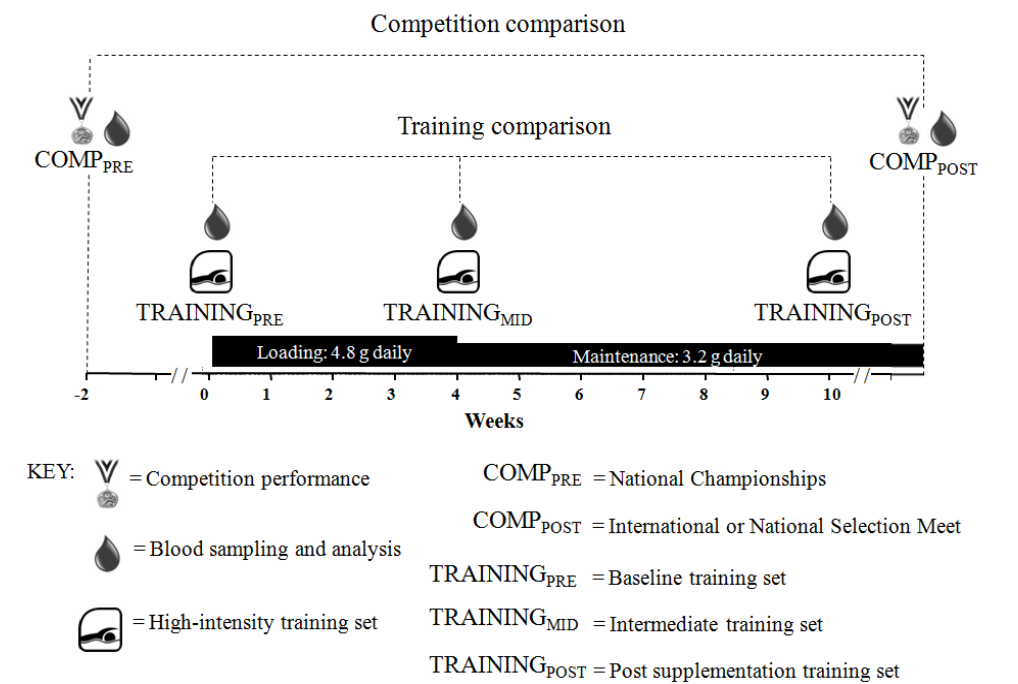
Figure 1. Schematic timeline of study